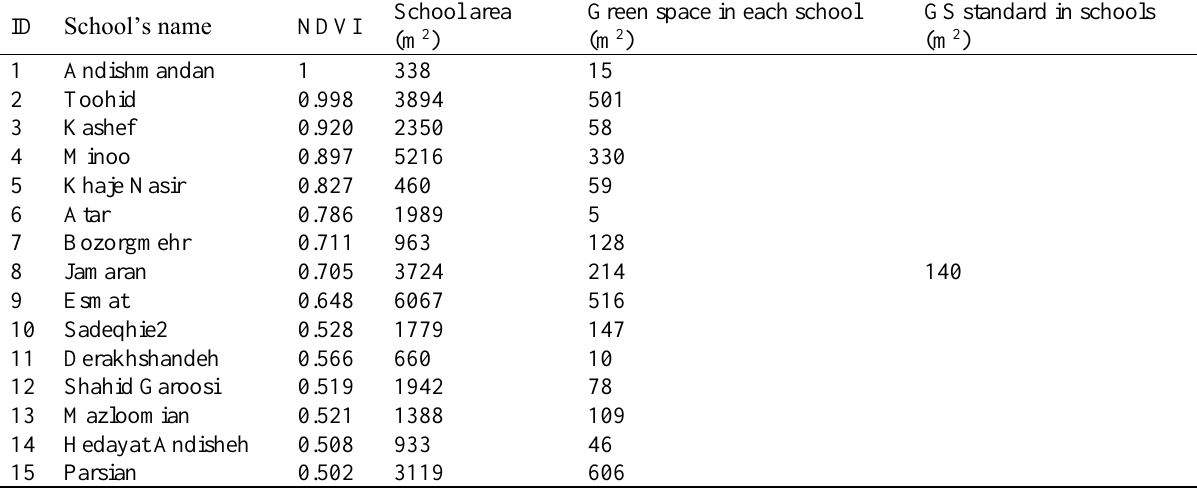
Table 2. Specifications of selected schools with highest value of green cover